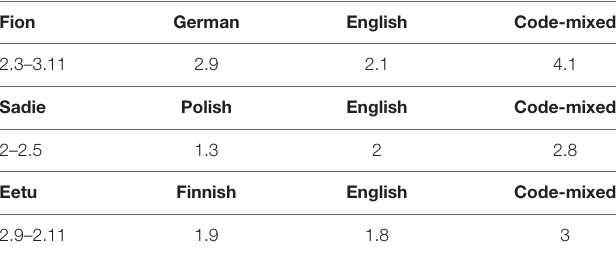
TABLE 2 | Mean length of utterances (MLU) for the monolingual and code-mixed utterances. Fion German English